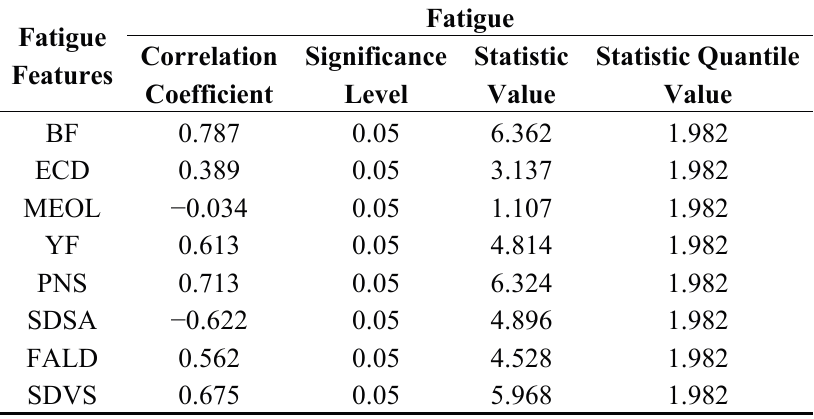
Table 4. Correlation analysis between fatigue features and